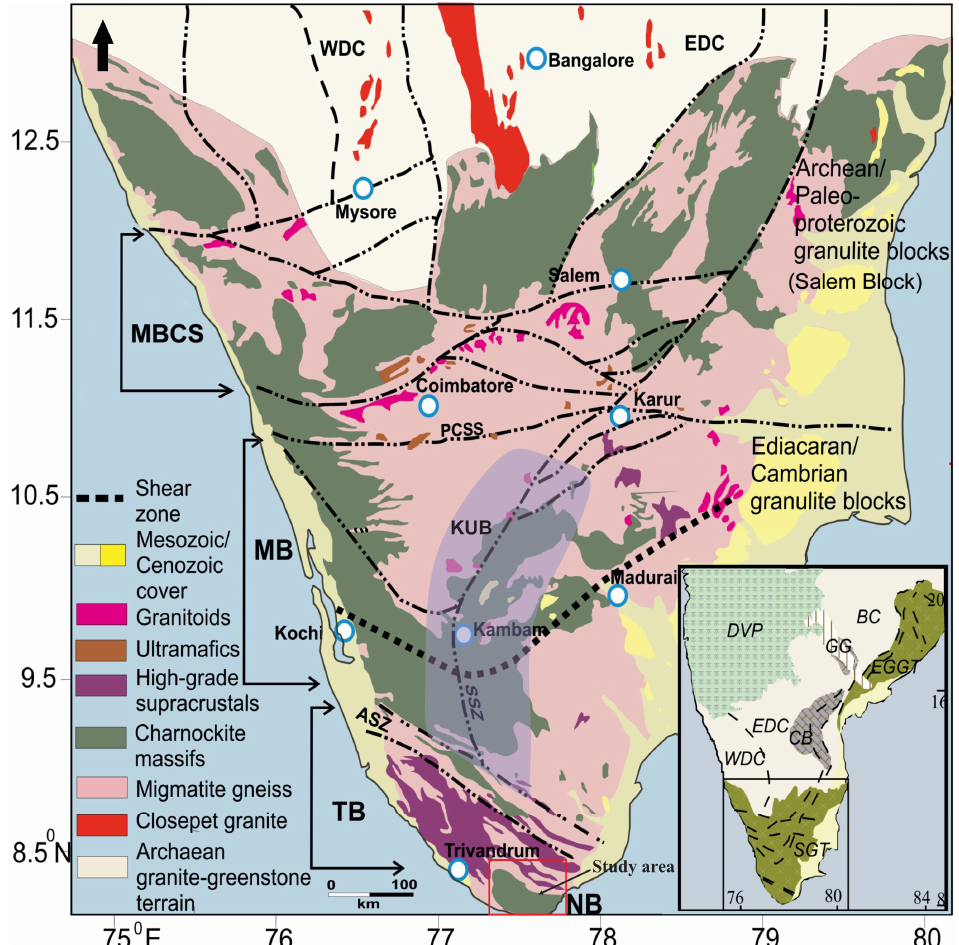
Figure 1. Simplified geological map of Southern Granulite Terrane (SGT; modified after [2]). Madurai block (MB), Trivandrum block (TB), Nagercoil block (NB), Western Dharwar Craton (WDC), Eastern Dharwar Craton (EDC), Moyar-Bhavani-Cauvery shear system (MBCS), Palghat-Cauvery shear system (PCSS), Suruli shear zone (SSZ), Karur-Kambam-Painavu-Trichur shear zone (KKPTSZ), Achankovil shear zone (ASZ), and Kambam UHT Belt (KUB). Inset shows the map of Indian peninsula: Deccan Volcanic Province (DVP), Bastar Craton (BC), Eastern Ghats Granulite Terrane (EGGT), Godaveri Graben (GG), and Cuddapah Basin (CB).